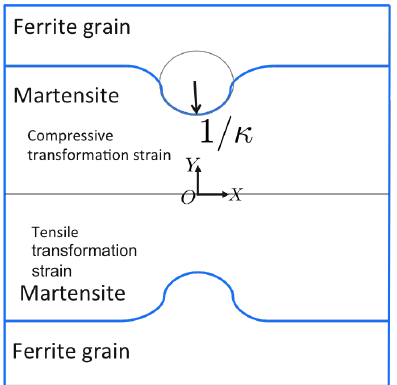
Figure 15. The volume element used for application of transformation strains, Table 5. κ = κ 2 is used.